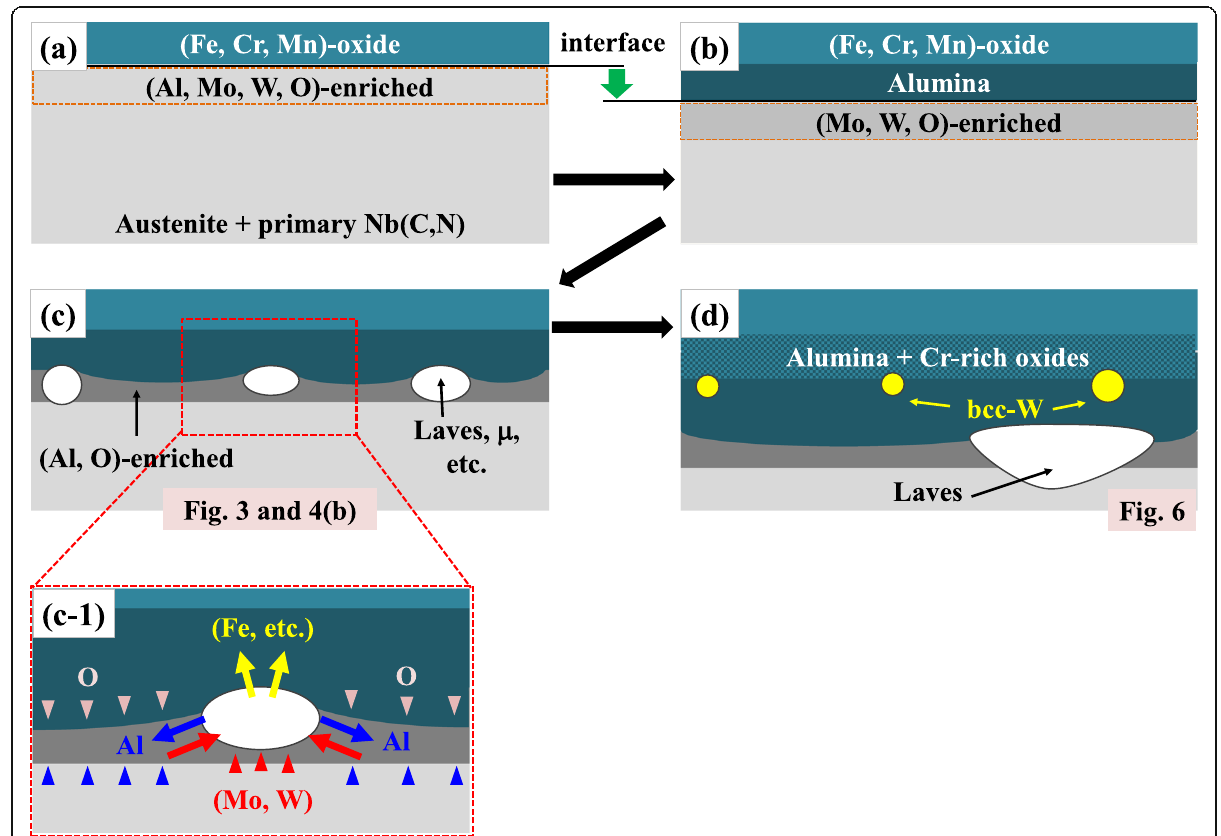
Fig. 9 Schematic description on the progress of oxidation in W5: the oxidation proceeds in the sequence from ( a ) to ( d ) and (c-1) is the magnified area within the broken box in ( c